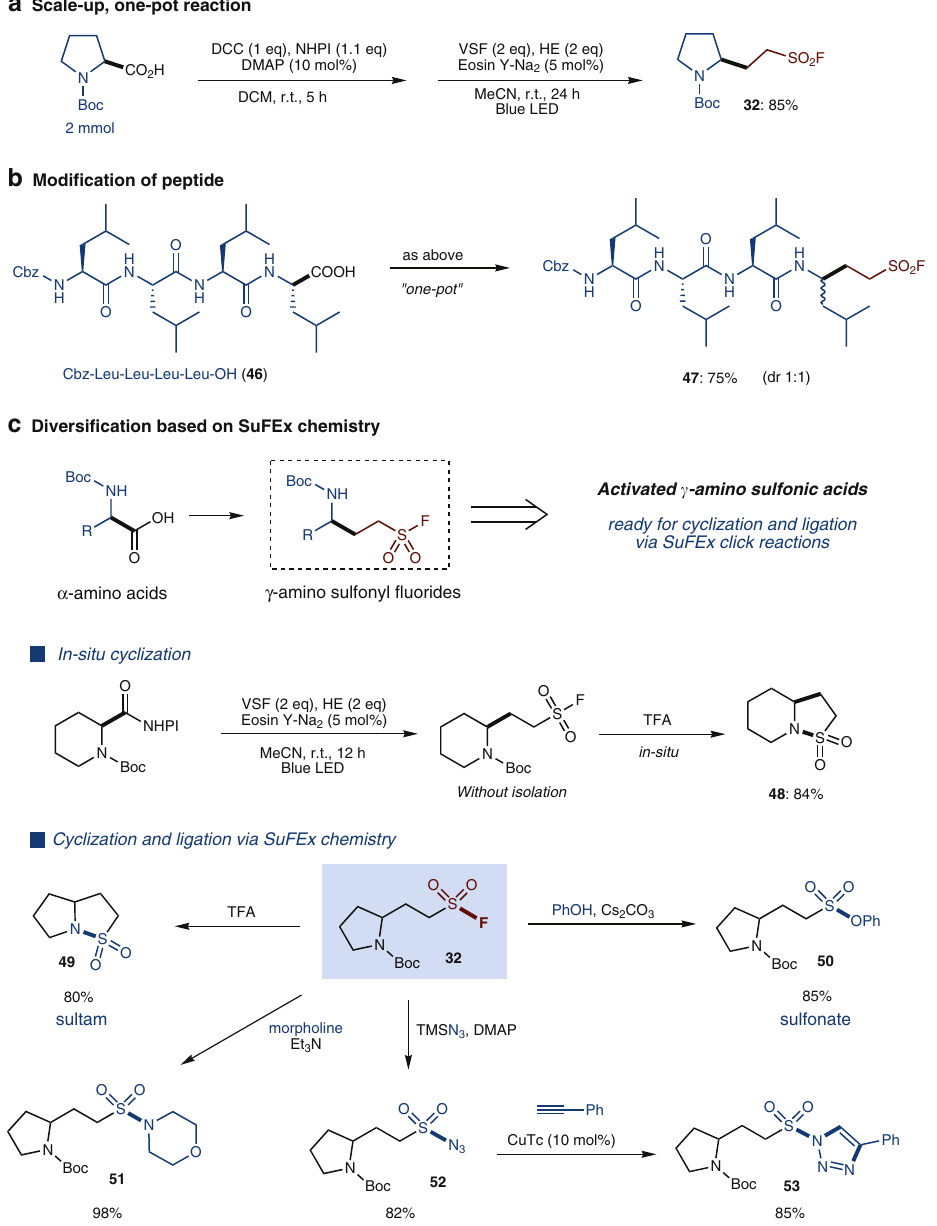
Fig. 3 Reaction practicability and diversi fi cation of products. a Scale-up, one-pot reaction. b Modi fi cation of peptide. c Diversi fi cation of products through SuFEx